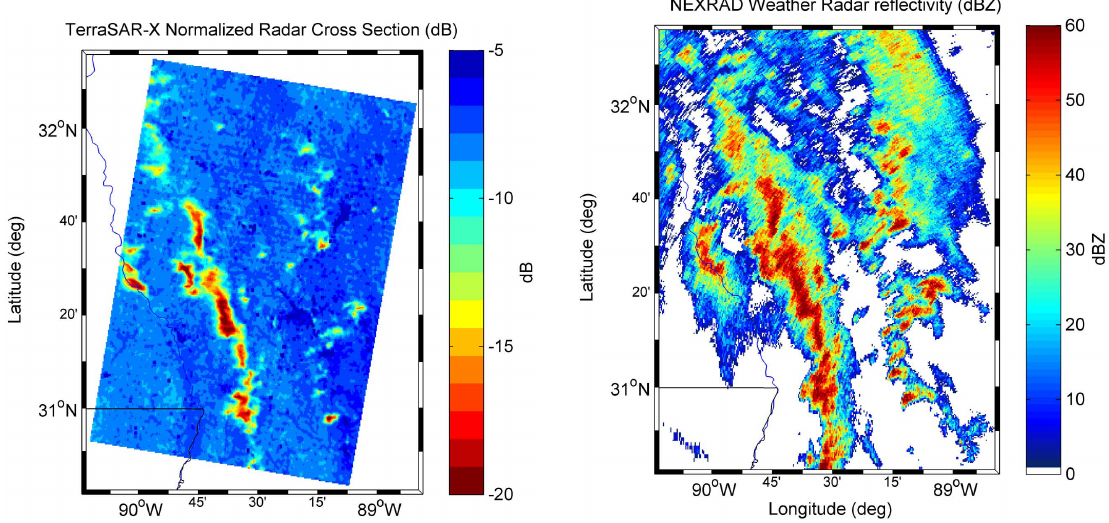
Fig. 4. Left: TSX calibrated NRCS (dB) for the selected case study in Fig. 1. TSX data have been filtered and resampled to about 0.5km resolution. Right: co-registered NEXRAD reflectivity factor Z PPI (dBZ) at 0.86 ◦ elevation angle at the same resolution of 0.5km.